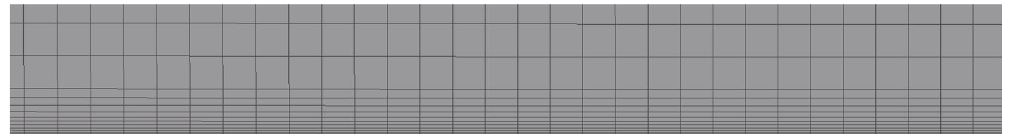
Figure 2: Local grid near the wall.